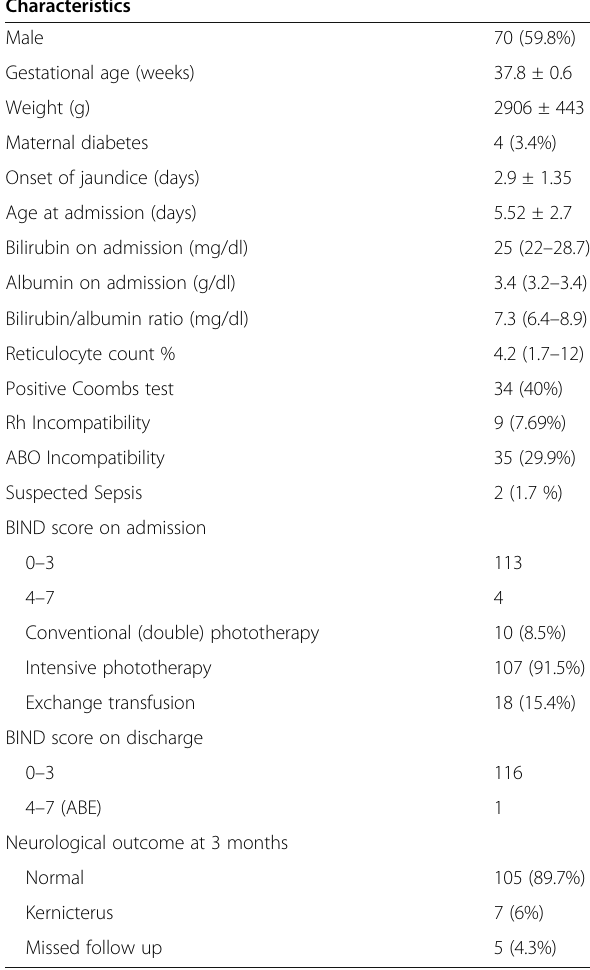
Table 2 Demographic and laboratory data of the studied population ( n =